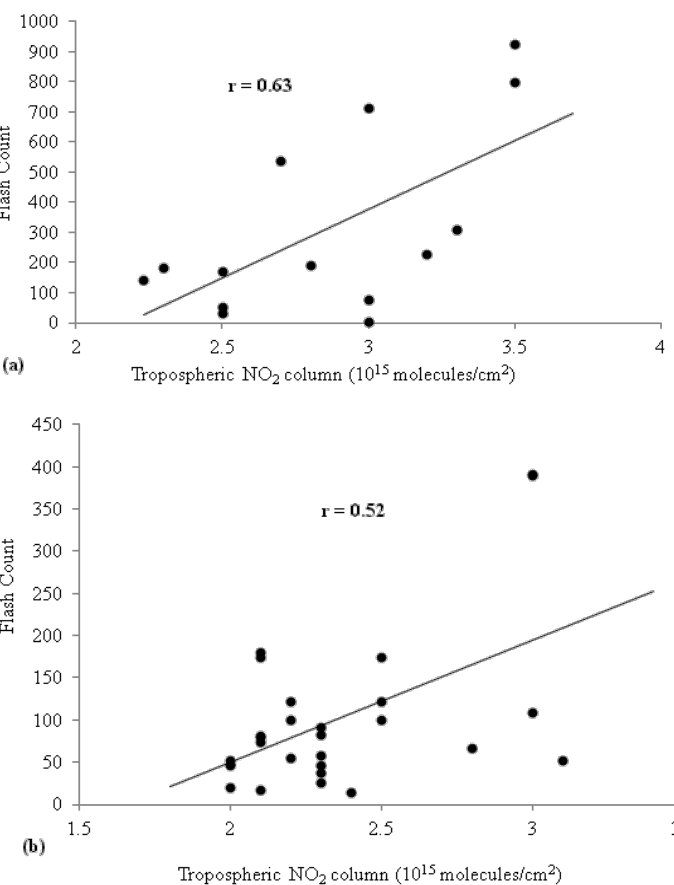
Figure 8. Scatter plot of tropospheric NO 2 column amount vs. lightning flash count for ( a ) pre-monsoon (April–May) and ( b ) monsoon (June–September) months from 2005 to 2011.